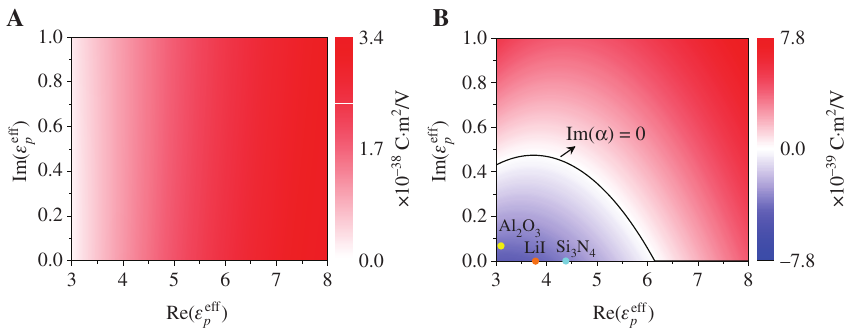
Figure 4: The distributions of (A) Re( α ) and (B) Im( α ) as a function of real and imaginary parts of a particle’s permittivity. The black line in (B) corresponds to the condition of Im( α ) = 0. The circle indicates the actual nanoparticles.